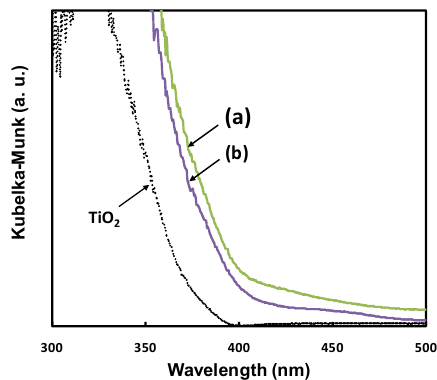
Figure 7. UV-visible diffuse reflectance spectra (DRS) of the SAOs prepared by ( a ) hydrothermal reaction and ( b ) sol–gel method.